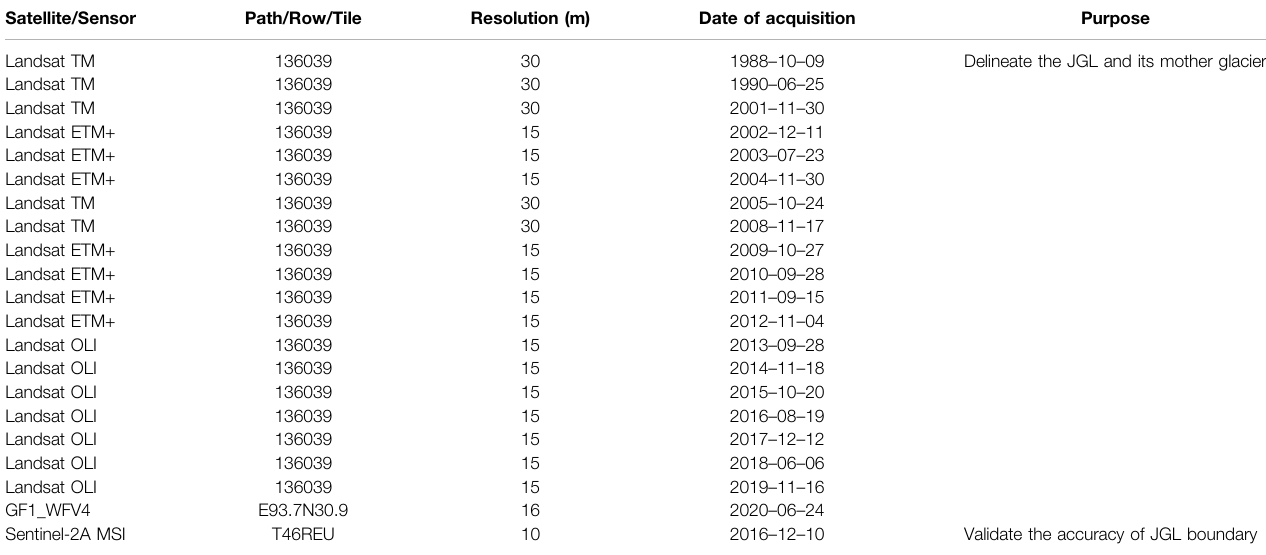
TABLE 1 | The information of the images used in this study.